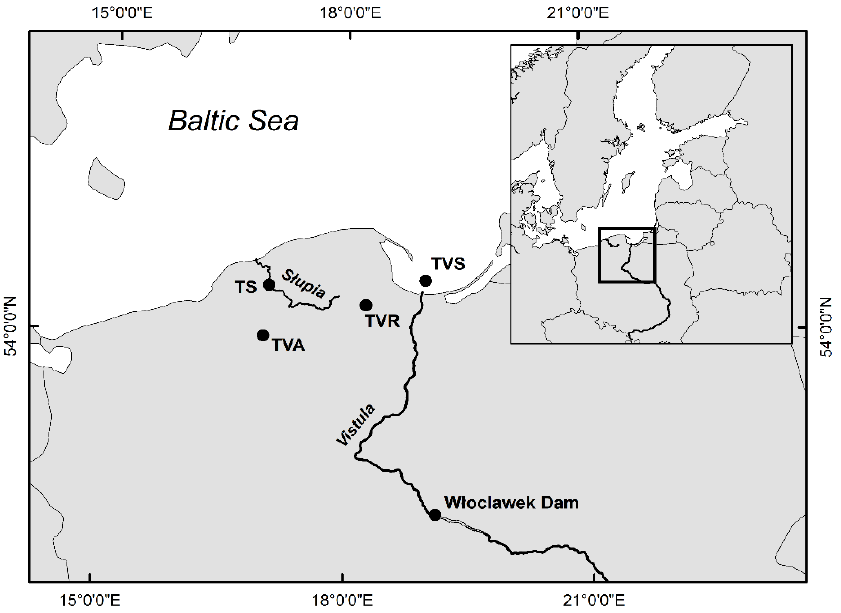
Figure 1. Map of the sites where sea trout were sampled in the Southern Baltic area. TS—S ł upia River; TVS— Ś wibno area, TVR—Rutki hatchery, TVA—Aquamar hatchery. TVS—´Swibno area, TVR—Rutki hatchery, TVA—Aquamar